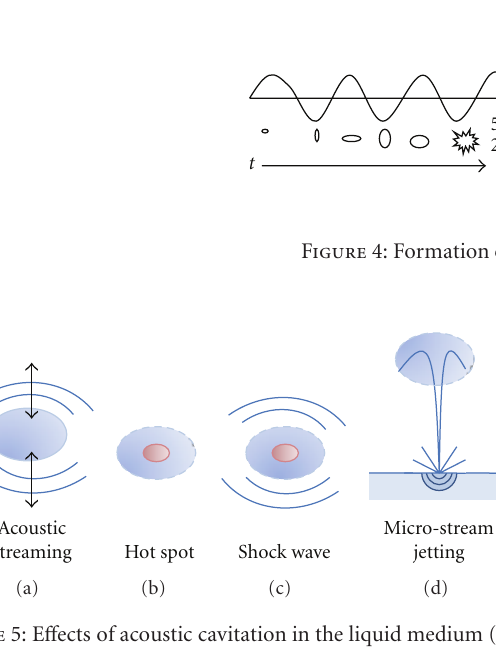
Figure 5: E ff ects of acoustic cavitation in the liquid medium ([56], reproduced with permission).